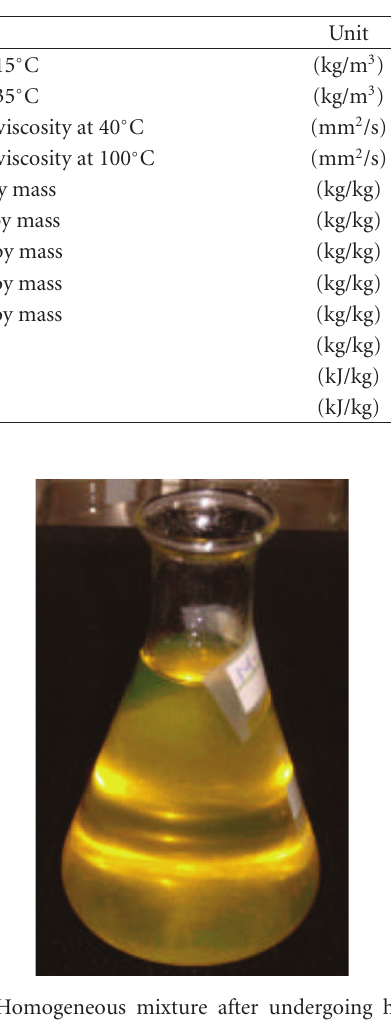
Table 3: Chemical and physical properties of lard and diesel.